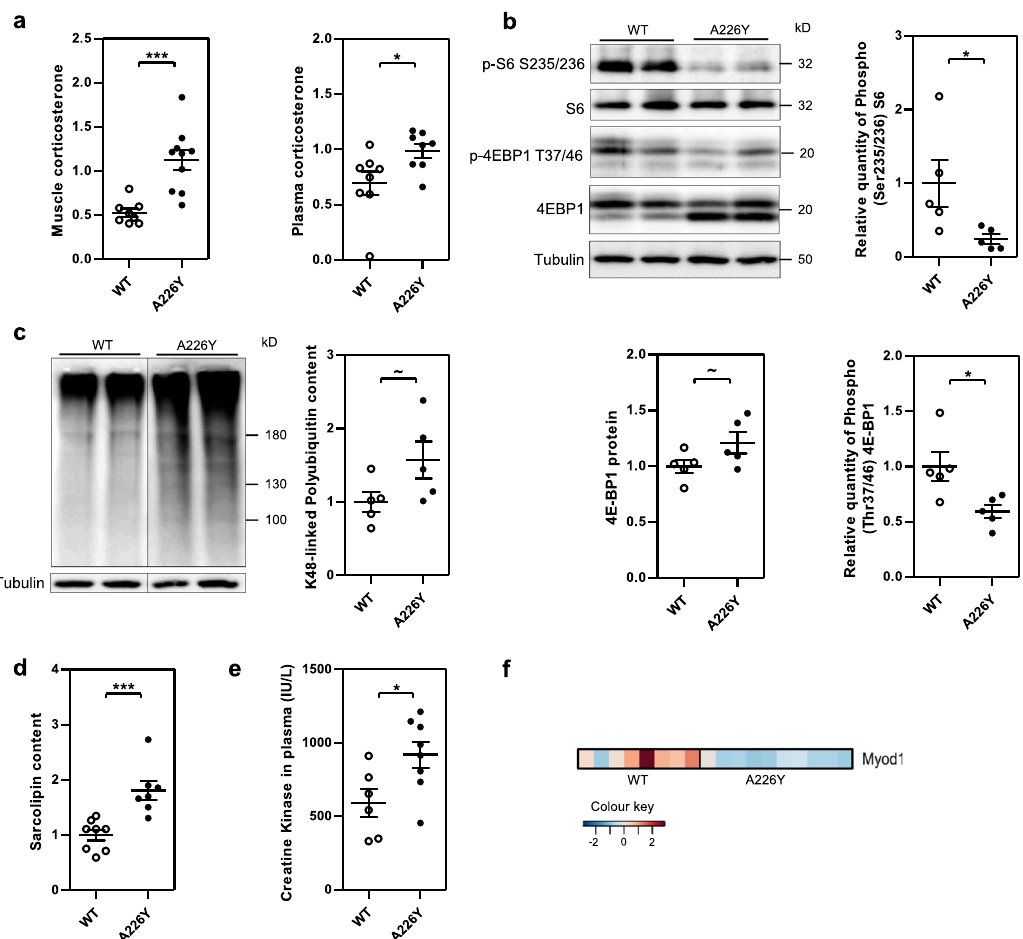
Fig. 4 Impact of Rps2 A226Y mutation in mice at 15 months of age. Graphs show mean, SEM and individual data points. *** p <0.001, ** p <0.01, * p <0.05, ~ p <0.1. a Corticosterone level in muscle and plasma in WT and A226Y mice (8 ≤ N ≤ 10). b Western blot and densitometry of total and speci fi c phosphorylated S6 and 4E-BP1 protein in WT and A226Y muscle ( N = 5). Tubulin as loading control. Relative quantity of phosphorylated protein calculated as phosphorylated/total. c Western blot and densitometry of polyubiquitylated proteins in WT and A226Y muscle ( N = 5). Tubulin as loading control. d Total sarcolipin content in the muscle of WT and A226Y mice as measured by ELISA ( N ≤ 7). e Creatine kinase levels in plasma (IU/l) (6 ≤ N ≤ 8). f Heatmap showing Myod1 mRNA expression in the muscle of WT and A226Y mice (adjusted p -value = 0.000813). N = number of independent mice in each